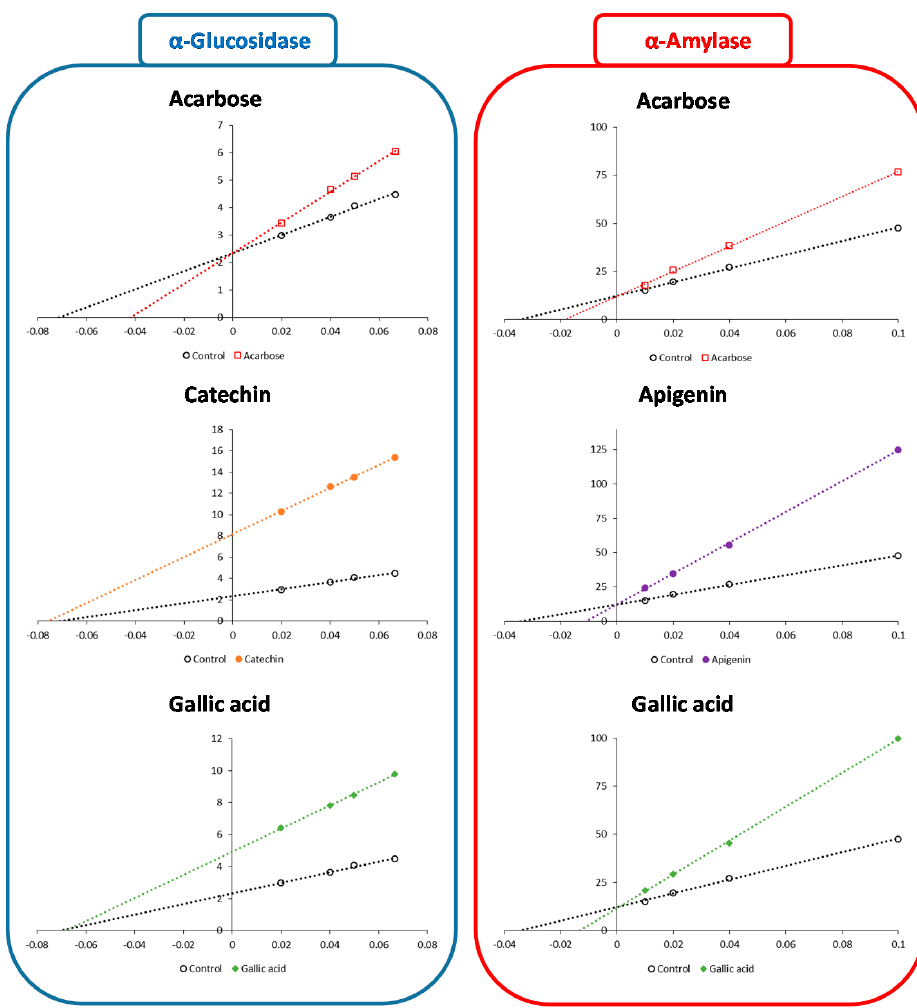
Figure 6. Lineweaver-Burk plots (with x = 1/v (v: velocity, in µmol/L); y = 1/[S] ([S]: substrate concentration in µM)) for inhibition of intestinal α -glucosidase by (-)-catechin (50 µM), gallic acid (50 µM), and acarbose (5 µM) and of pancreatic α -amylase by apigenin (50 µM), gallic acid (50 µM), and acarbose (5 µM). Table 1. Kinetic parameters of intestinal α -glucosidase and pancreatic α -amylase inhibitions.